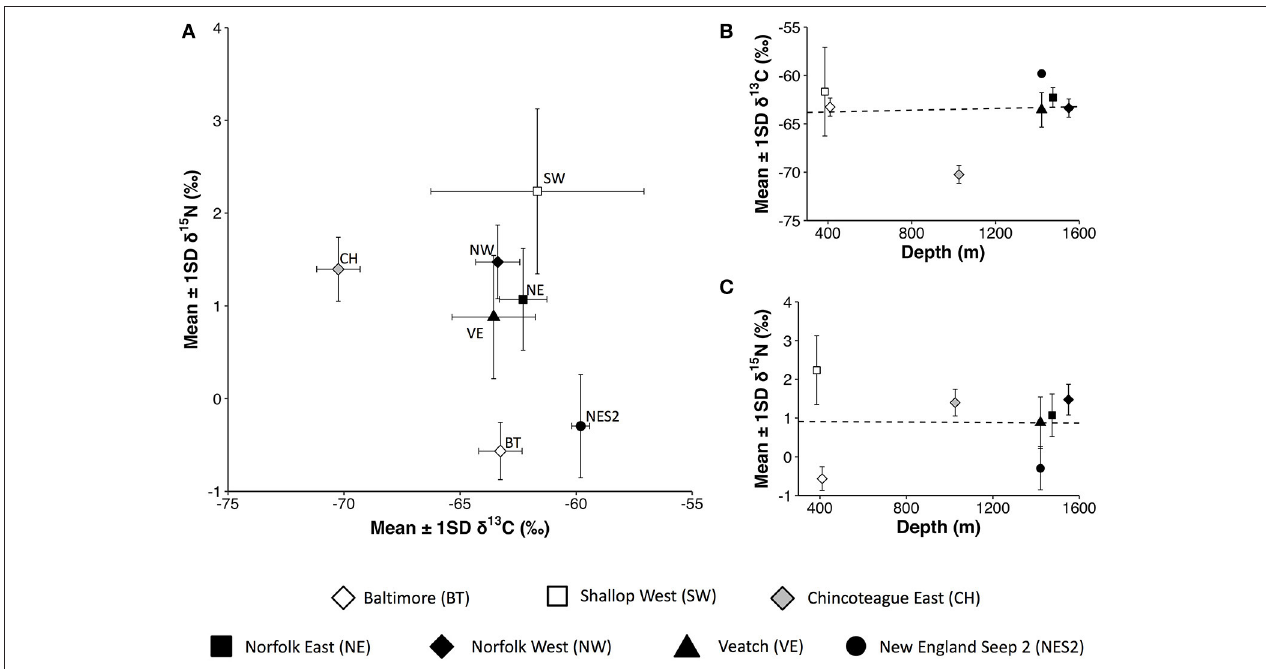
FIGURE 3 | Bathymodiolus childressi stable isotope biplot and relationships with depth. (A) δ 15 N vs. δ 13 C ( ‰ ). (B) δ 13 C ( ‰ ) vs. Depth (m). (C) δ 15 N ( ‰ ) vs. Depth (m). White symbols: shallow sites ( ∼ 400m), gray symbol: intermediate depth ( ∼ 1,000m); black symbols: deep sites ( ∼ 1,500m). Dashed lines: linear regression for δ 13 C [ F δ 15 N [ F (1, 5) = 0.026, p = 0.88, r 2 = 0.005, slope = 4.6 × 10 − 4 ] and (1, 5) = 0.0013, p = 0.97, r 2 = 2.3 × 10 − 4 , slope = − 3.2 × 10 − 5